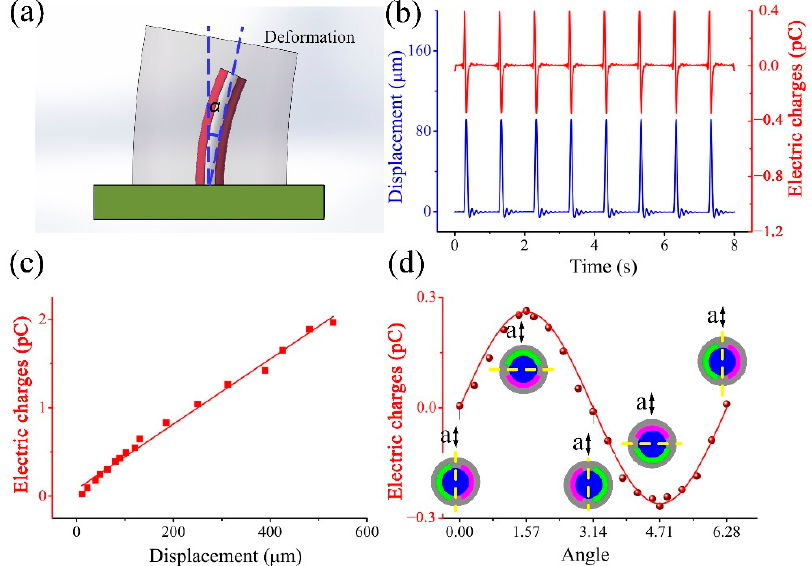
Figure 2. ( a ) A diagram of the experimental system. ( b ) Transverse deformation displacement and output charges of the SMPF under impact oscillation. ( c ) The relation between the deformation amplitude of the SMPF sensor and its output charges. ( d ) The relation between the SMPF sensor output charges and the included angle between the impact oscillation direction and the electrode interface on the SMPF sensor